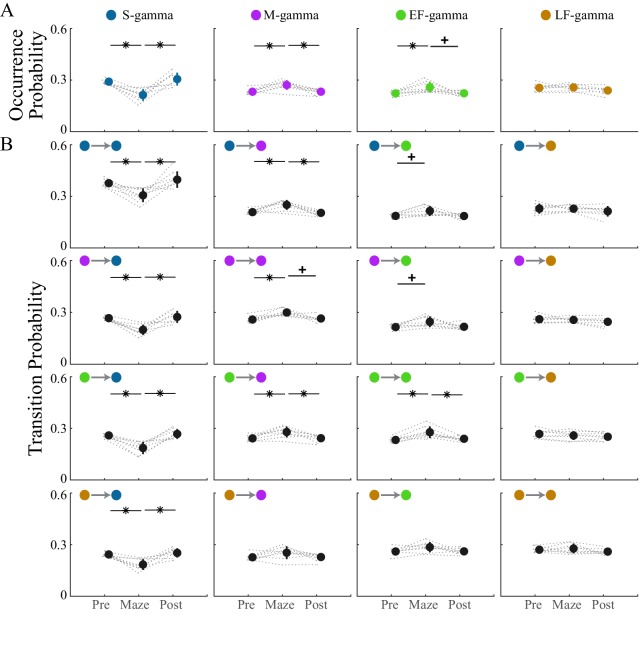
Transition matrix and occurrence of the four TG states during awake periods.(A) TG state occurrence of the four states are presented in four graphs; comparisons are made across sessions. Note that in total 60 = [4 × 4 (transition matrix) + 4 (occurrence)] × 3 (pairs of session) comparisons are made (paired t test). (B) A 4 × 4 graph display shows the transition probability from the current state (row) to the next state (column); in each individual graph, the transition probabilities are compared across three experimental sessions (pre-maze period, maze period, and post-maze period). * denotes significant difference, FDR correction for 60 comparisons (q < 0.05); + denotes less strict statistics (q < 0.1).